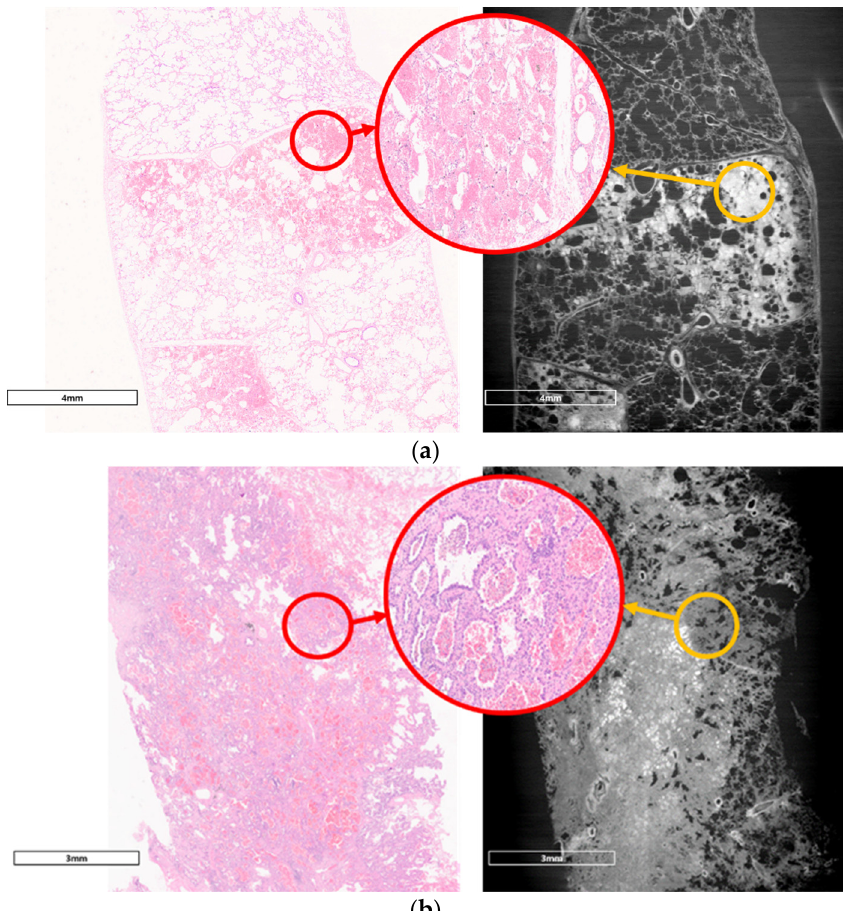
Figure 5. Comparison of pathologic findings and SR images. ( a ) Pathologic image of normal lung tissue and SR image. Hemorrhage inside normal alveolar structure (small red circle) was identified in × 100 magnified image (left side). Normal alveolar structures including alveolar septa and microvasculature were identified in a × 400 magnified image (large red circle in middle). The SR image on the right side is similar to the × 100 magnified light microscope (LM) image. The hemorrhage lesion was identified; however, it was not clear compared with that of the × 400 magnified LM image. ( b ) Pathologic image of lung adenocarcinoma and SR image. Destruction of alveolar structure and interstitial thickening was well noticed both in × 100 magnified LM image (left side) and SR image (right side). However, hyperproliferation and thickening of alveolar lining cells (large red circle in middle) could not be observed in SR